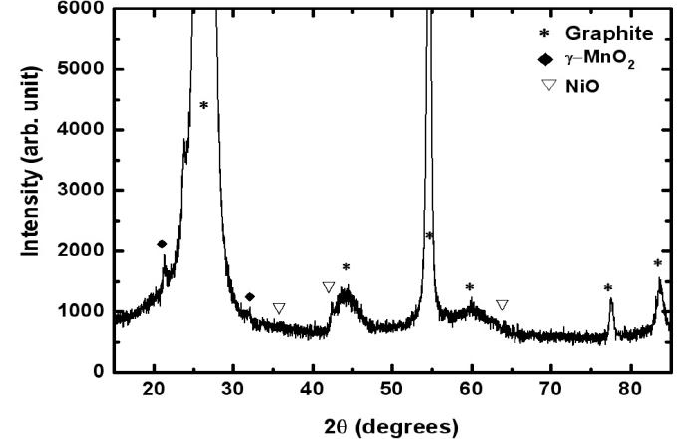
Figure 3. XRD spectrum of the electrodeposited Mn-Ni oxide